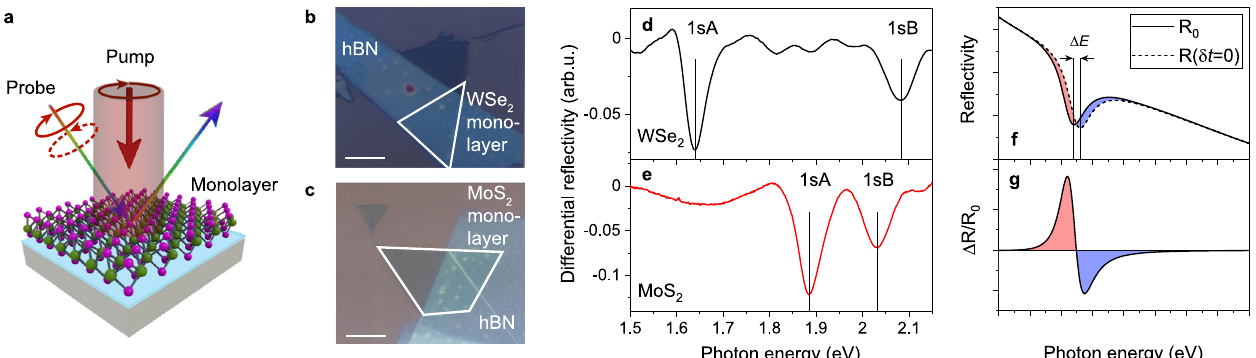
Fig. 1 Coherent optical Stark and Bloch Siegert shifts in 2D TMDs. a Layout of the experimental setup used for transient re fl ection spectroscopy of TMDs. The monolayer is pumped with an infrared circularly polarized pump pulse and probed by a broadband circularly polarized pulse, whose spectrum is measured. b , c Optical microscope images of the studied samples of TMDs. White polygons mark the monolayers. The size of the white scale bar is 10 μ m. Differential re fl ectivity spectra of WSe 2 ( d ) and MoS 2 ( e ) monolayers. f Sketch of the monolayer re fl ectivities without ( R 0 ( ℏ ω )) and with the pump pulse at zero delay time δ t = 0 between the pump and probe pulses R ( ℏ ω , δ t = 0). The distance Δ E between the two extrema of the re fl ectivities manifests the shift of exciton energy due to pump pulse. g Sketch of the transient re fl ectance contrast [ R ( ℏ ω , δ t = 0) − R 0 ( ℏ ω )]/ R 0 ( ℏ ω ). Its peak-and-dip shape explains the experimental data presented in Figs. 2c and